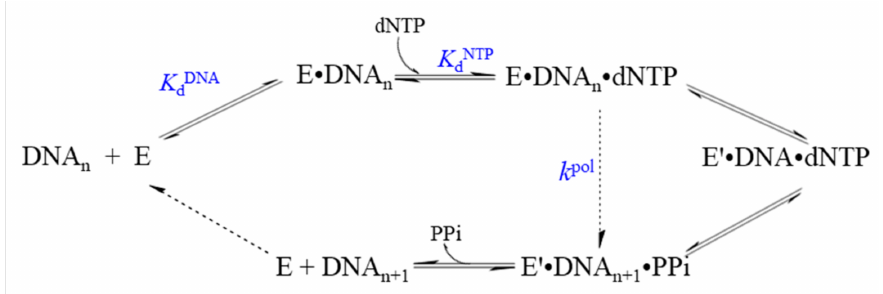
Scheme 4. Minimal single-nucleotide incorporation reaction pathway for Pol β and Pol λ